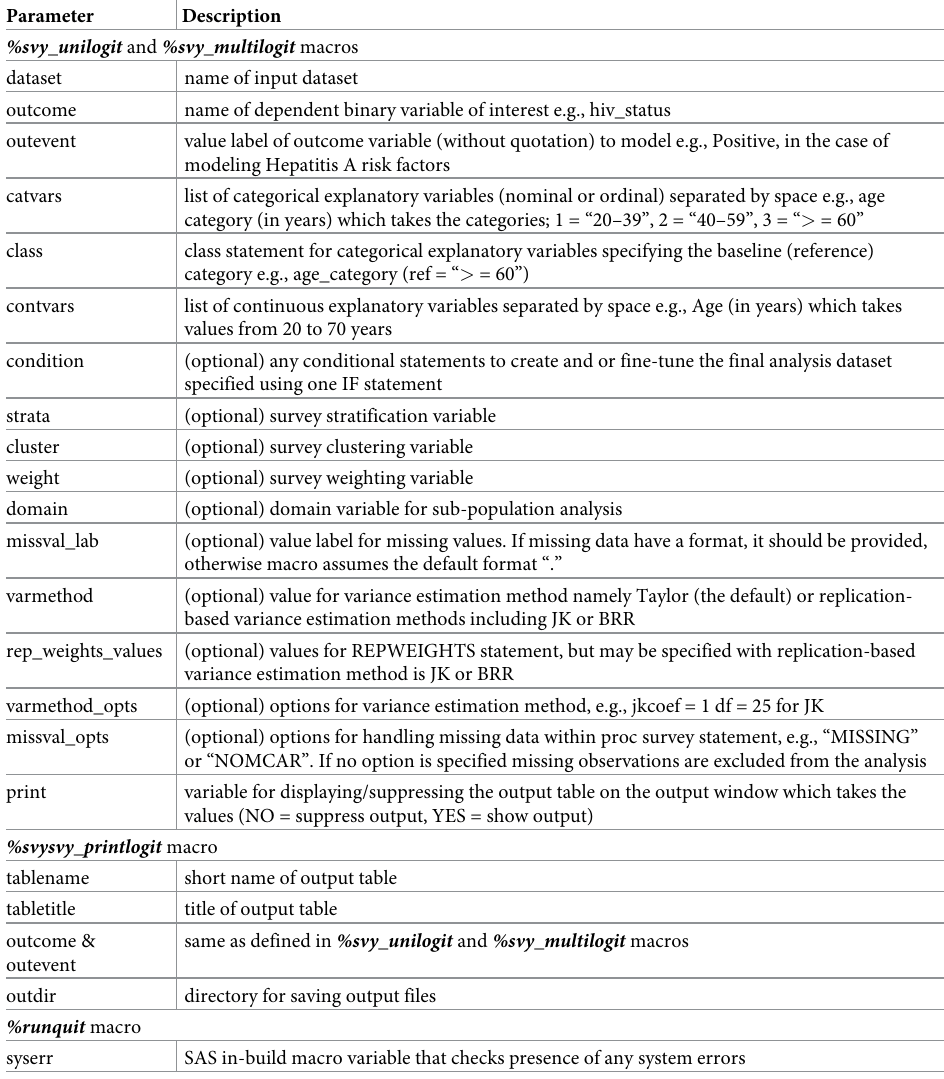
Table 1. Input parameters for %svy_unilogit , %svy_multilogit and %svy_printlogit